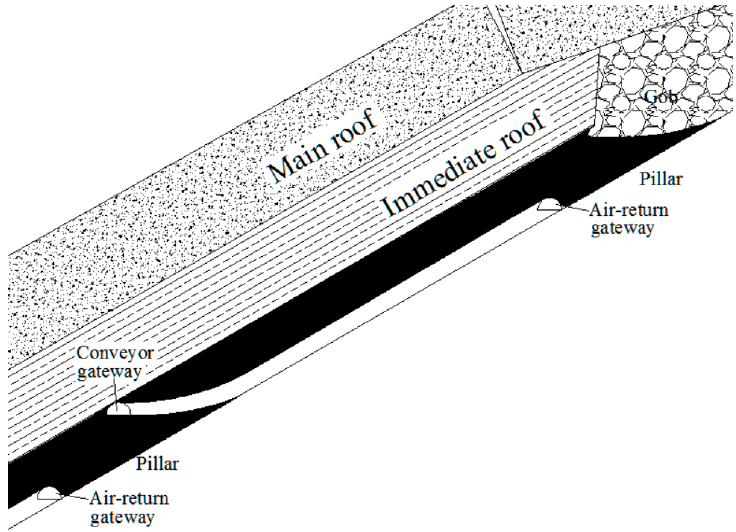
Figure 13. LMSG in cases of accumulated water or large gas content within gob .